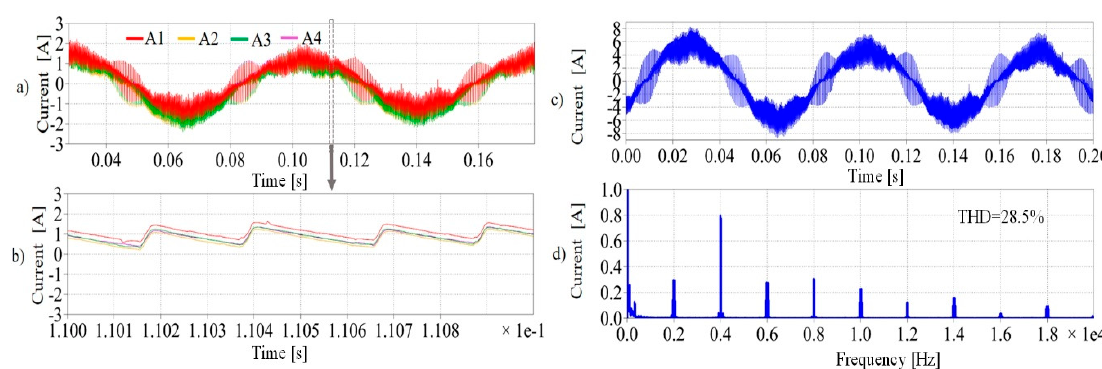
Figure 5. ( a , b ) Experimental result of phase currents without phase-shift CPWM. ( a ) Two fundamental Figure 5. ( a ),( b ) Experimental result of phase currents without phase-shift CPWM. (a) Two period range. ( b ) The cursor range of Figure 5a,c,d. Equivalent phase current without phase-shift fundamental period range. ( b ) The cursor range of Figure 5a,5c,5d. Equivalent phase current without CPWM. ( c ) Time-domain current waveform. ( d ) FFT spectrum of Figure phase-shift CPWM. ( c ) Time-domain current waveform. (d) FFT spectrum of Figure 5 c .